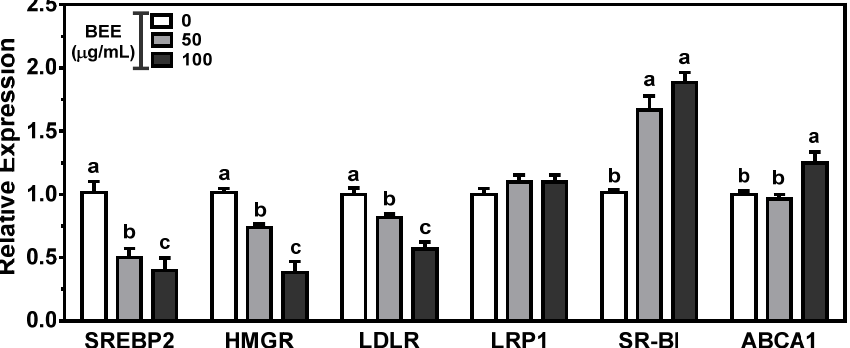
Figure 1. Expression of genes for cholesterol biosynthesis and absorption in BEE-treated HepG2 cells. Cells were treated with 50 or 100 µ g/mL of BEE for 24 h. The gene expression was measured by qRT-PCR analysis. Data are expressed as relative expressions to control. Different letters indicate significant differences ( p < 0.05). Values are means ± S.E.M. n = 6.